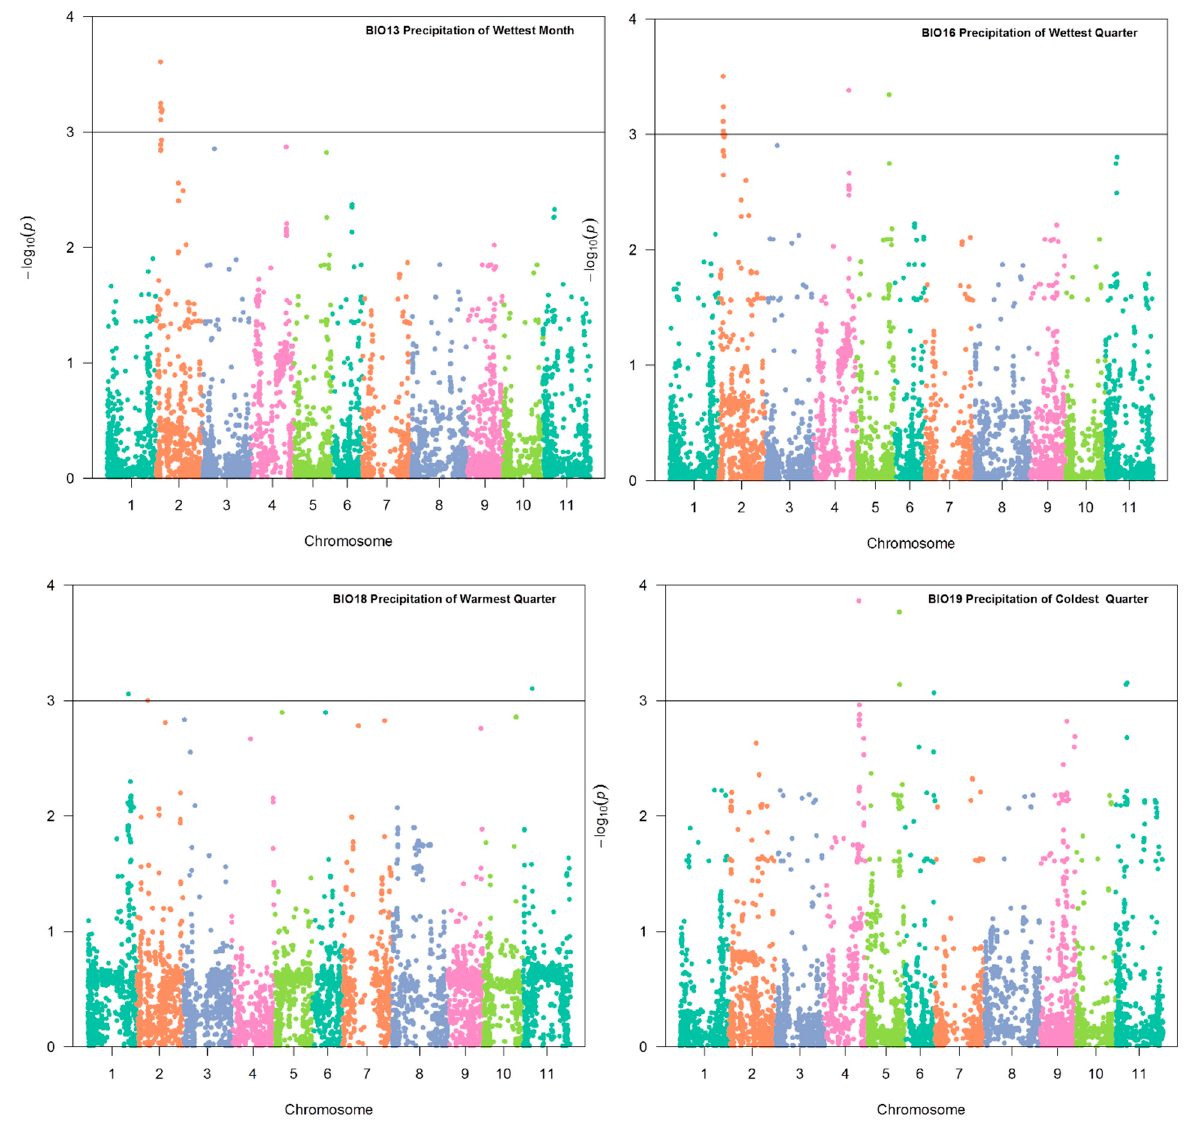
Figure 6. Genome–environment association analysis in common bean accessions. Manhattan plot showing candidate single nucleotide polymorphisms and − log10 ( p -values) for bio-climatic variables BIO13, BIO16, BIO18, and BIO19. The horizontal black line corresponds to the significance threshold with p -value equal to or smaller than 0.001%.